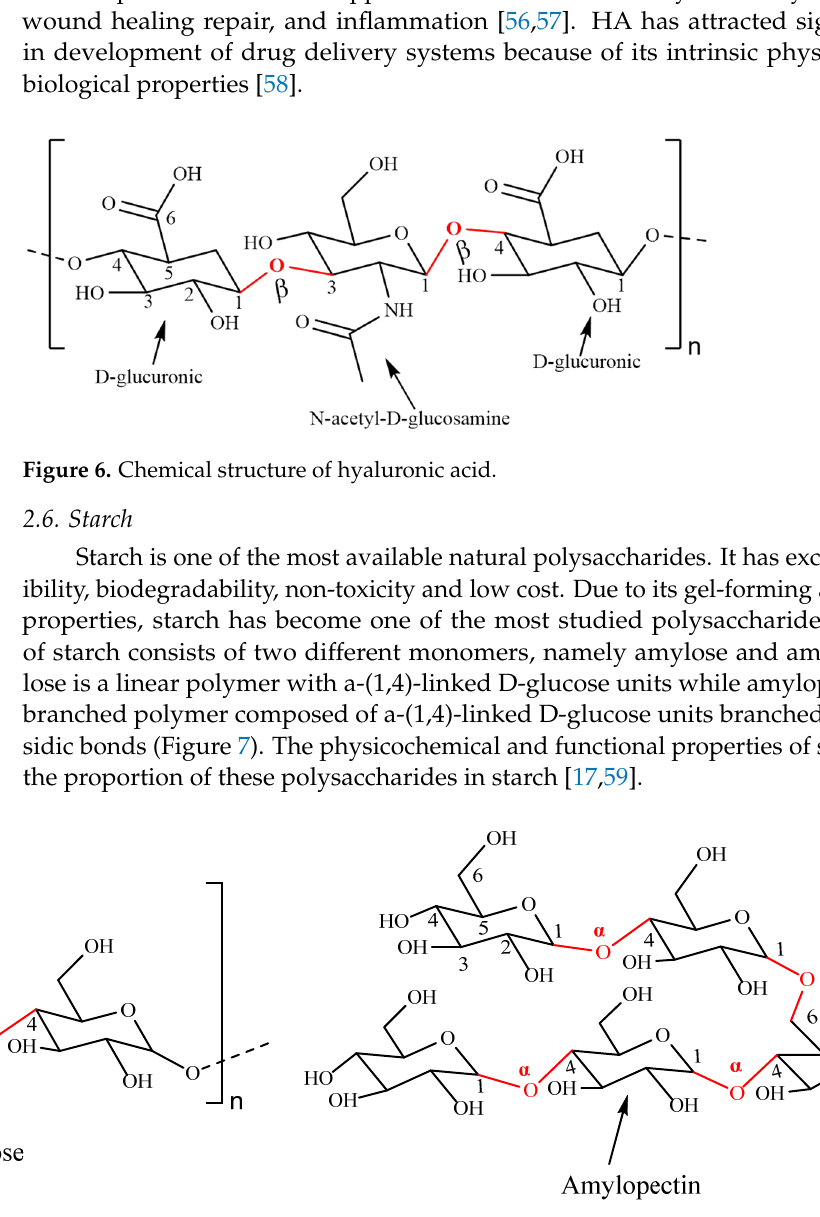
Figure 7. Structure of amylose and amylopectin.